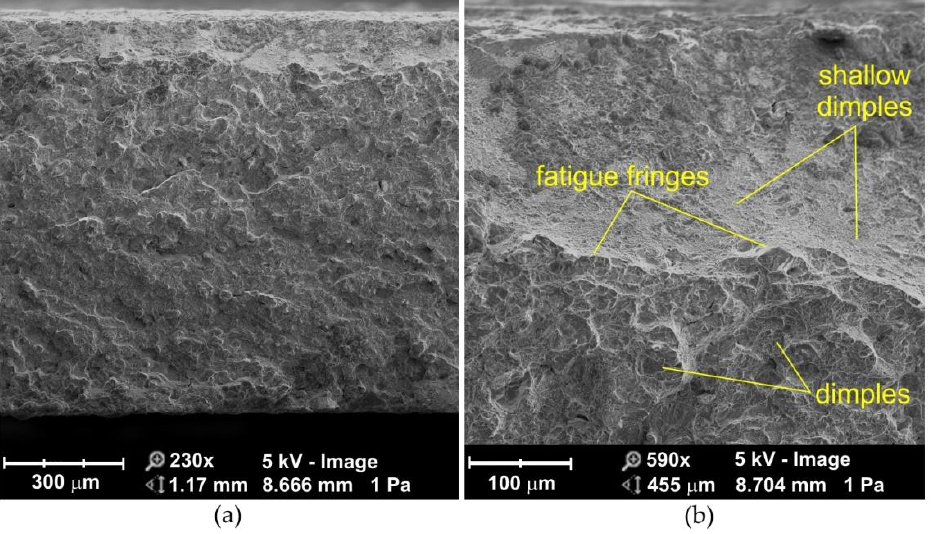
Figure 9. SEM micrographs of the fatigue fracture of sandblasted flash butt welded joints tested at a stress amplitude of 575 MPa: ( a ) cross-section of the fatigue fracture, ( b ) view of the near-edge layer of the weld.